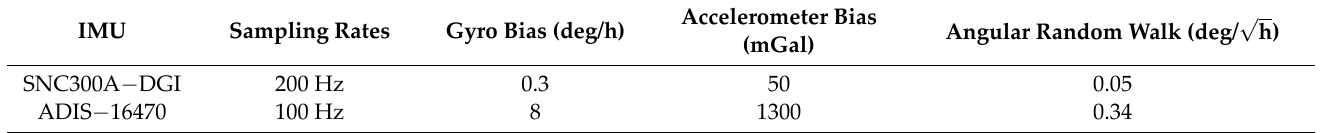
Table 2. Processing strategy of PPP − B2b/INS.